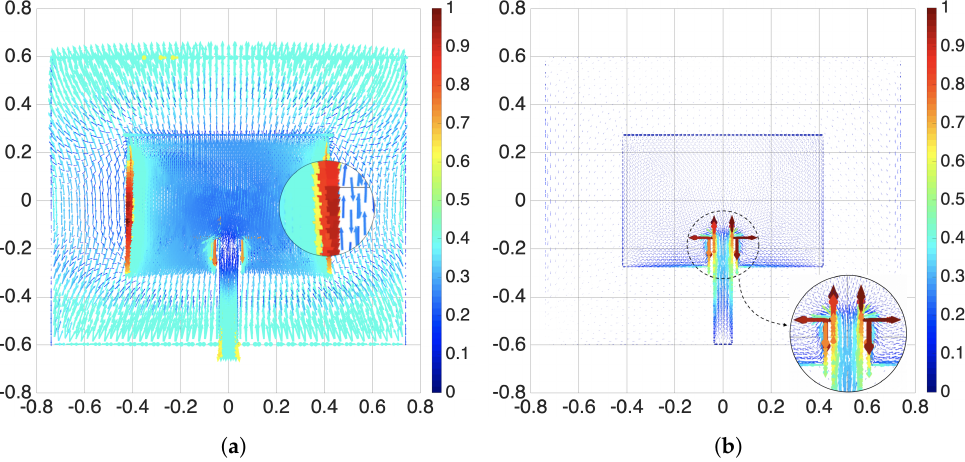
Figure 12. Electric current density J for modes f rAL ( a ) #4, and ( b ) #6 of Table 1, flowing on the metallic portions of the patch antenna, i.e., the top isle, feeding line and the